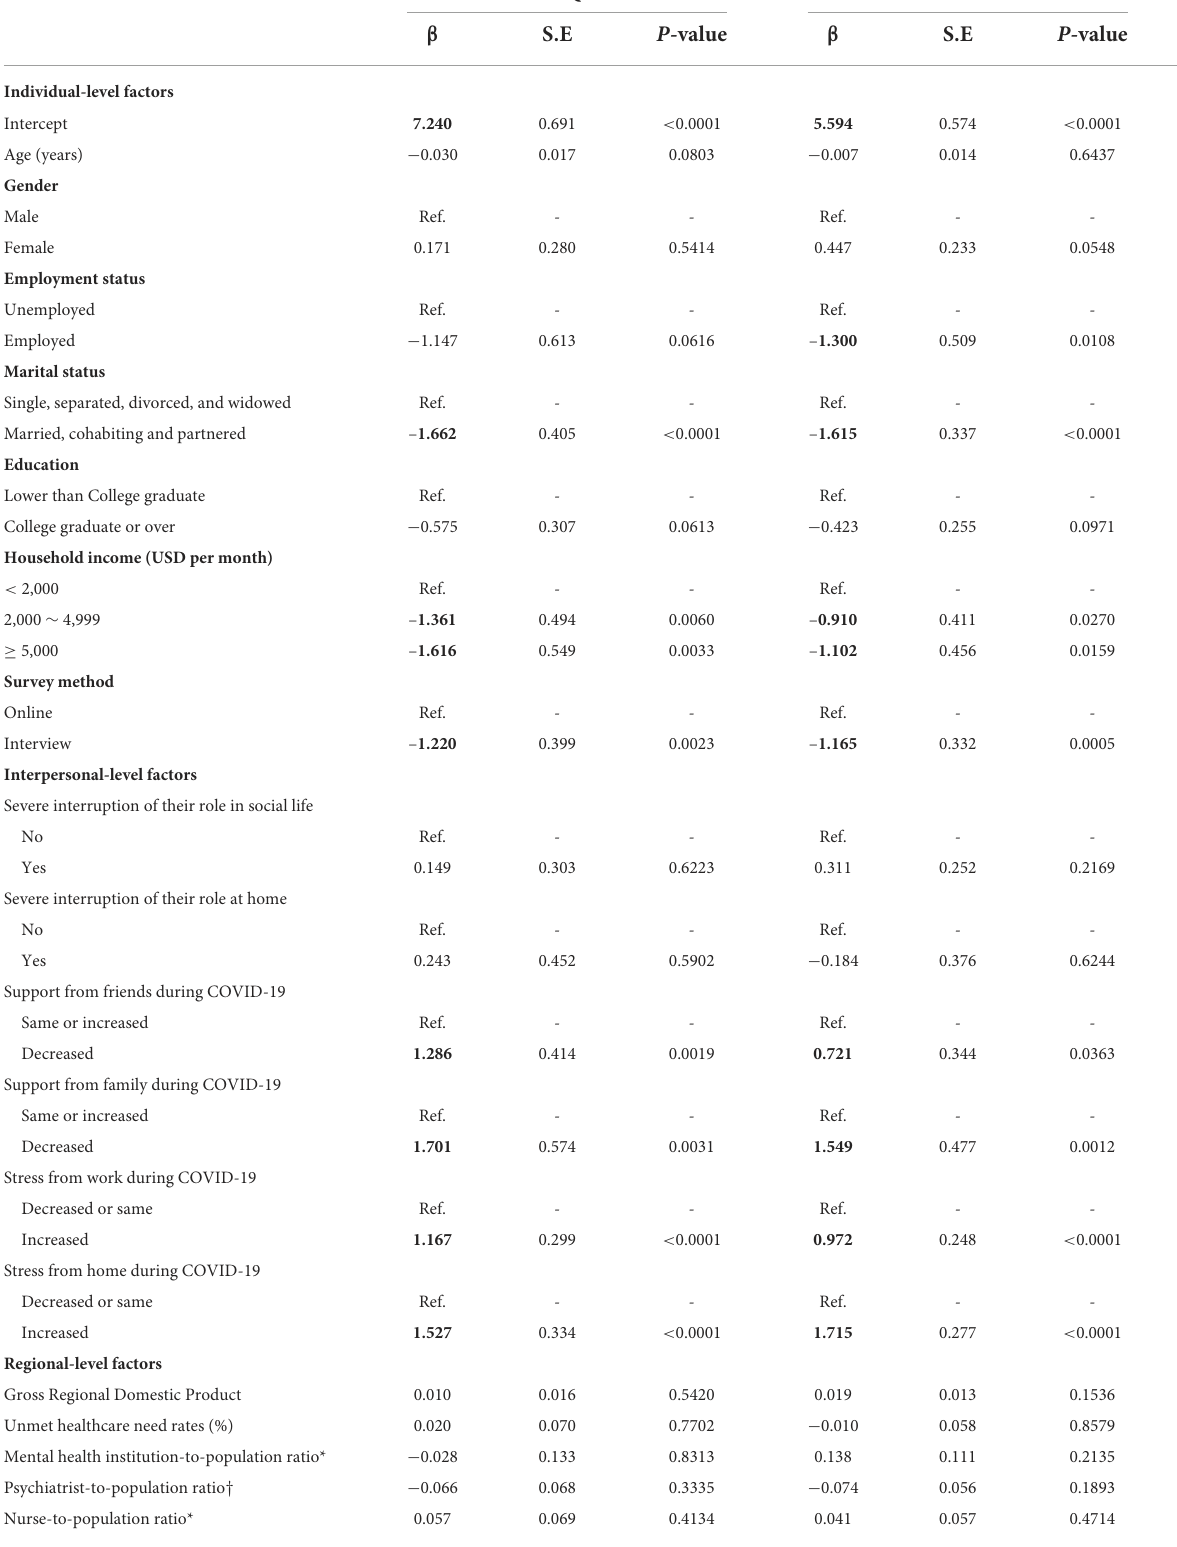
TABLE 2 Multiple linear regression for the effect of individual and community factors on individual’s mental health